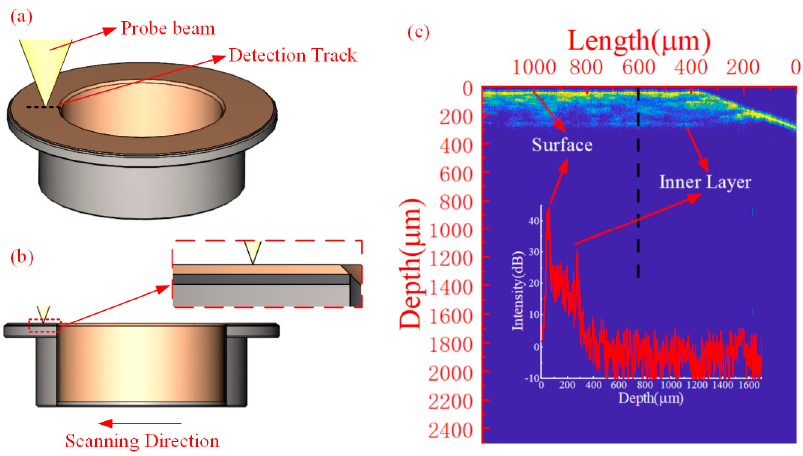
Figure 7. The tomographic image of the end face of the sliding bearing’s liner: ( a ) schematic diagram of bearing detection track; ( b ) schematic diagram of inner structure of liner; ( c ) the tomographic image.